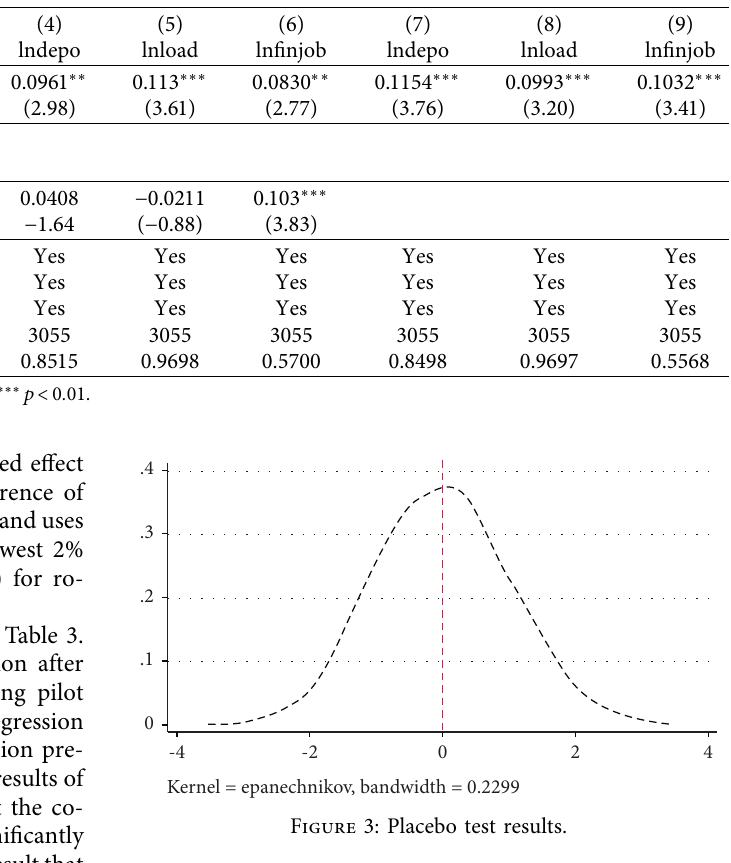
Table 3: Robustness tests.